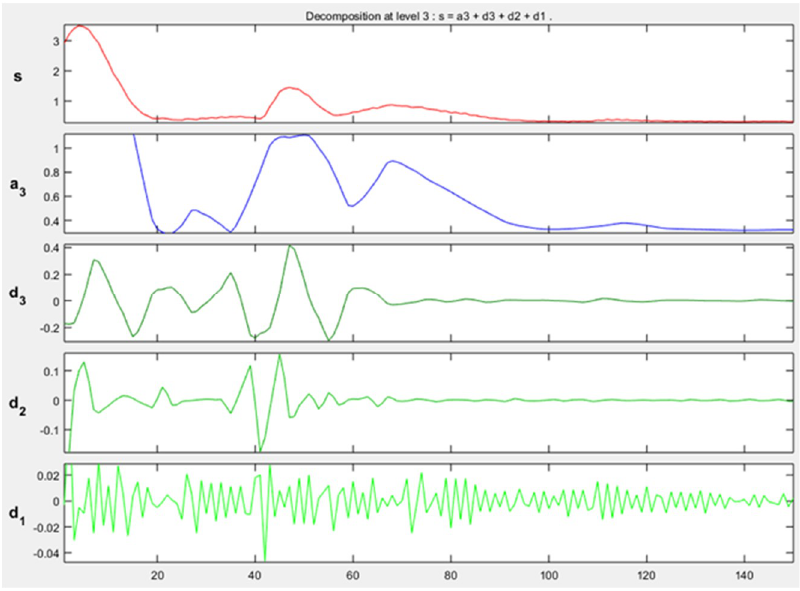
Figure 13. Example of approximation and detail coefficients, approximation to level 3 related to one double upward movement.